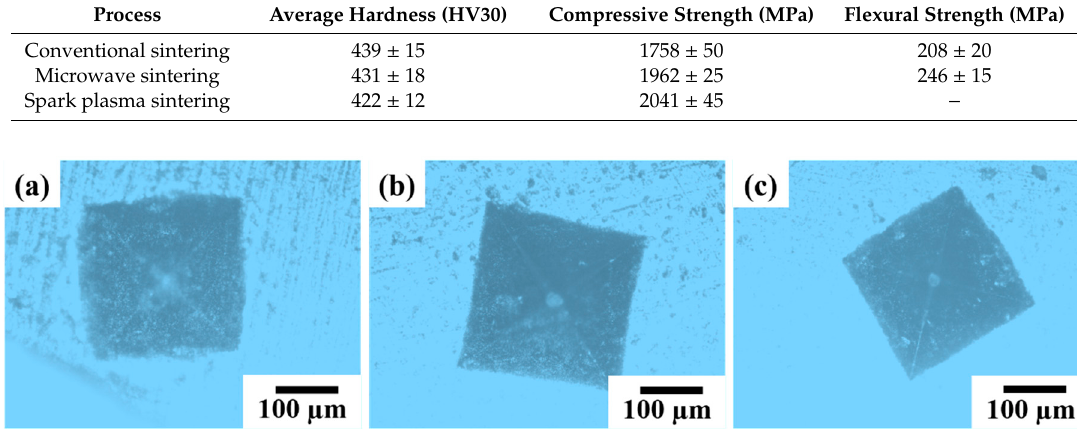
Table 5. Mechanical properties of alloy in di ff erent heating modes.